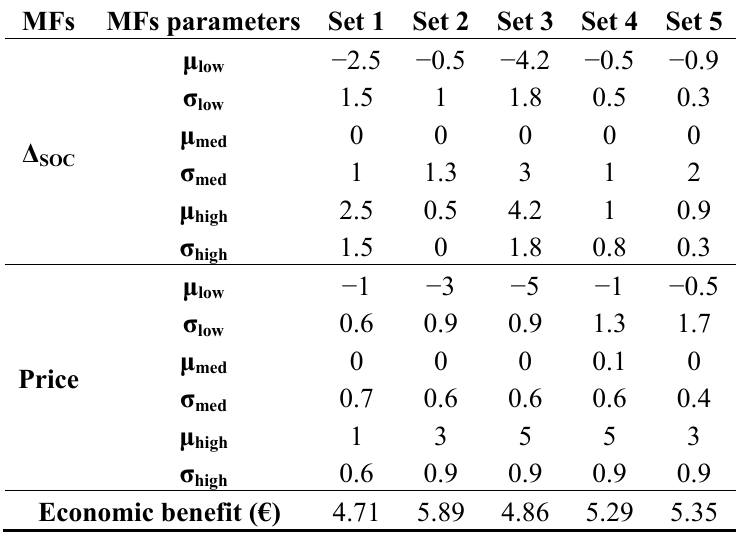
Table 3. Economic benefit with static parameters—unstable